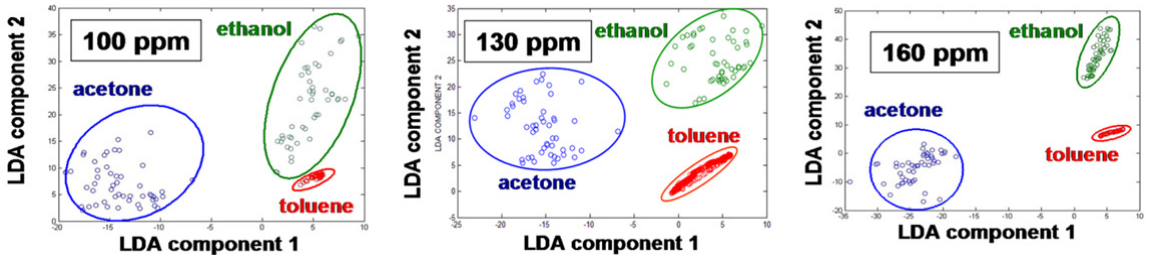
Figure 5. Separation of classes of chemicals in two-dimensional slices of multidimensional hyperspace using LDA technique at three different vapor